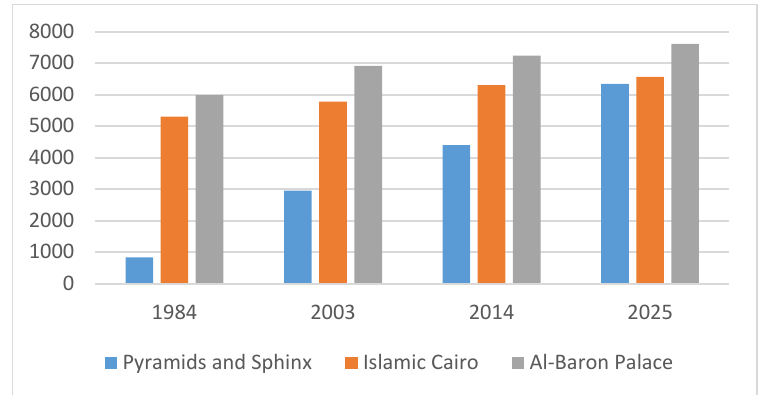
Figure 8. Total area of urban patches within 5-km buffer around cultural monuments